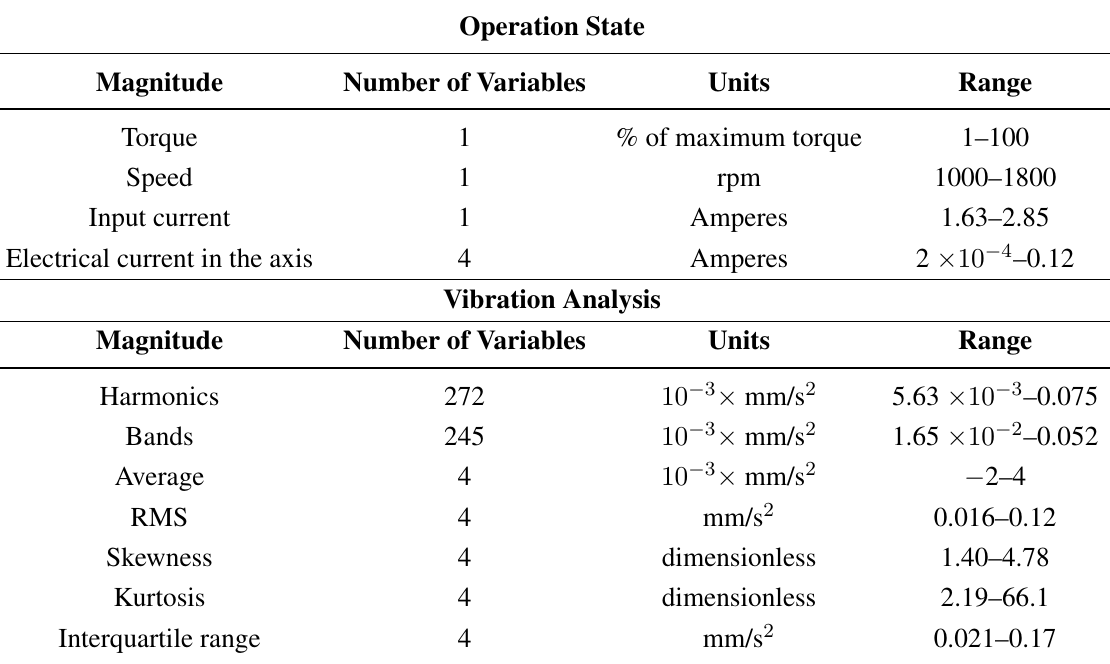
Table 2. Variables included in the final